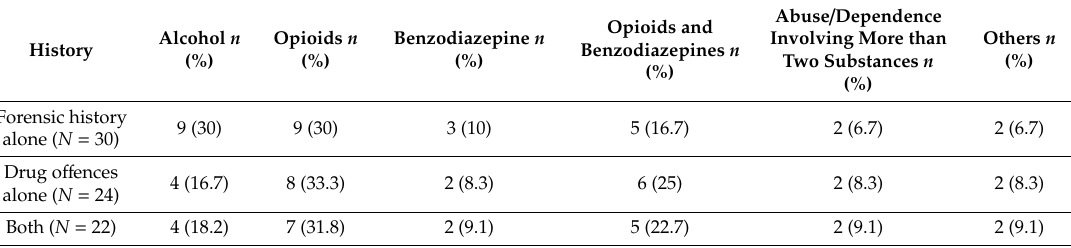
Table 6. Forensic history of the